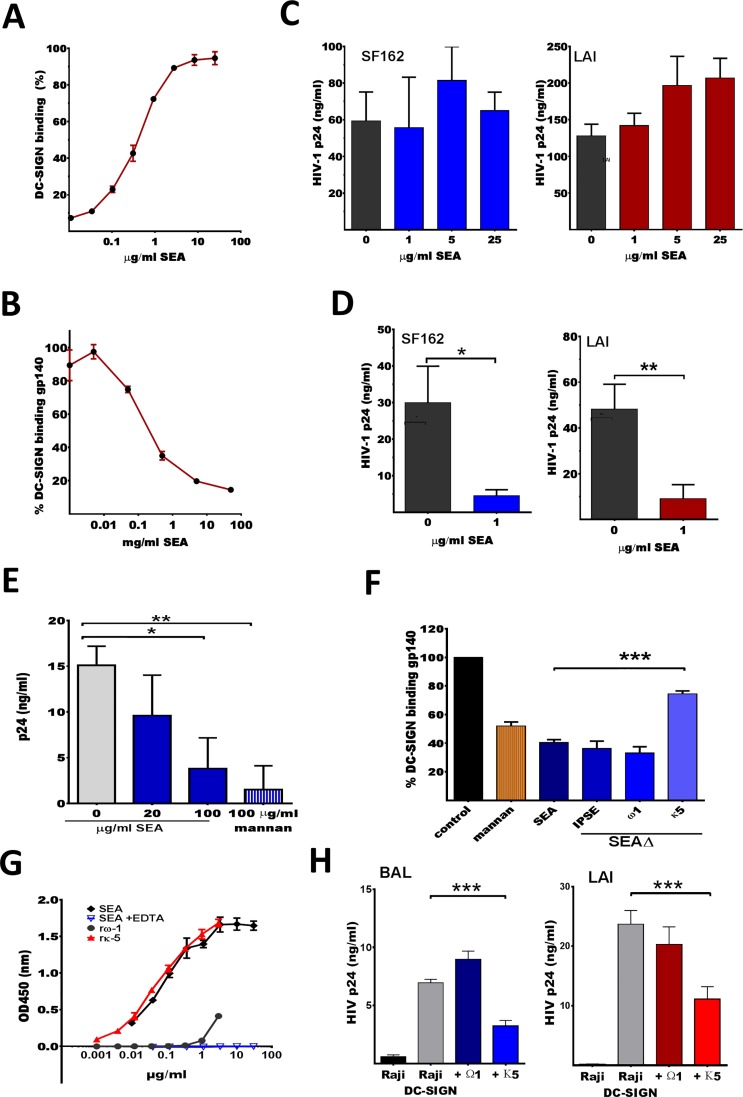
SEA binds DC-SIGN and can block trans-infection of CD4 T-lymphocytes but not cis-infection.(A) DC-SIGN binding ELISA where DC-SIGN-Fc was added to 5 fold serial dilutions of SEA coated onto an ELISA plate, the highest OD450 was set to 100% binding with ±SEM shown. (B) A gp140 competition ELISA where DC-SIGN-Fc was incubated with serial dilutions of SEA for 30min at RT prior to addition to a trimeric gp140 coated ELISA plate (captured via an HIV-1 Env antibody). The highest OD450 was set to 100%, implying that 0.01μg/ml SEA will not block DC-SIGN-Fc binding to gp140. (C) Effect of SEA on cis-infection was determined by adding SEA 2h prior to SF162 (R5) or LAI (X4) to CD4+ enriched T-lymphocytes. Viral outgrowth was monitored through measuring p24 levels in culture supernatant at either day 5 or 7 of infection. (D) SEA’s effect on trans-infection was determined by pre-incubating Raji DC-SIGN cells with 1μg/ml SEA for 2h and subsequently adding SF162 (TCID50 5000) or LAI (TCID50 500). Viral outgrowth in Raji DC-SIGN—CD4+ T-lymphocyte co-cultures was monitored through measuring p24 levels in culture supernatant. (E) Similarly, iDC were incubated with SEA or mannan (positive control) for 30min prior to addition of SF162 (TCID50 200). Viral outgrowth in iDC—CD4+ T-lymphocyte co-cultures was monitored through measuring p24 levels in culture supernatant at either day 5 or 7 of infection. (F) SEA components rκ5 (1.7μg/ml), IPSE or rω-1 (both 2μg/ml) were examined in the gp140 competition ELISA. The OD450 of DC-SIGN-Fc binding to gp140 is set to 100% and binding of SEA pre-incubated DC-SIGN-Fc is plotted as a percentage of this 100%. Pre-incubating DC-SIGN-Fc with any of the SEA fractions or mannan resulted in a significant decrease (p<0.05) in gp140 binding. (G) SEA as well as rω-1 or rκ5 were coated at limiting dilution on an ELISA plate and analyzed for DC-SIGN-Fc binding. (H) Recombinant protein effects on trans-infection were determined by pre-incubating Raji DC-SIGN cells with rω-1 (10 µg/ml) or rκ5 (10 µg/ml) for 2h and subsequently adding BAL (TCID50/ml 1000) or LAI (TCID50/ml) virus followed by enriched CD4+ lymphocytes and measuring p24 levels in culture supernatant on day 5. (B-H) Experiments were performed in triplicate and data shown as mean of these triplicates with ±SD. *p< 0.05,**p<0.01, ***p<0.001.